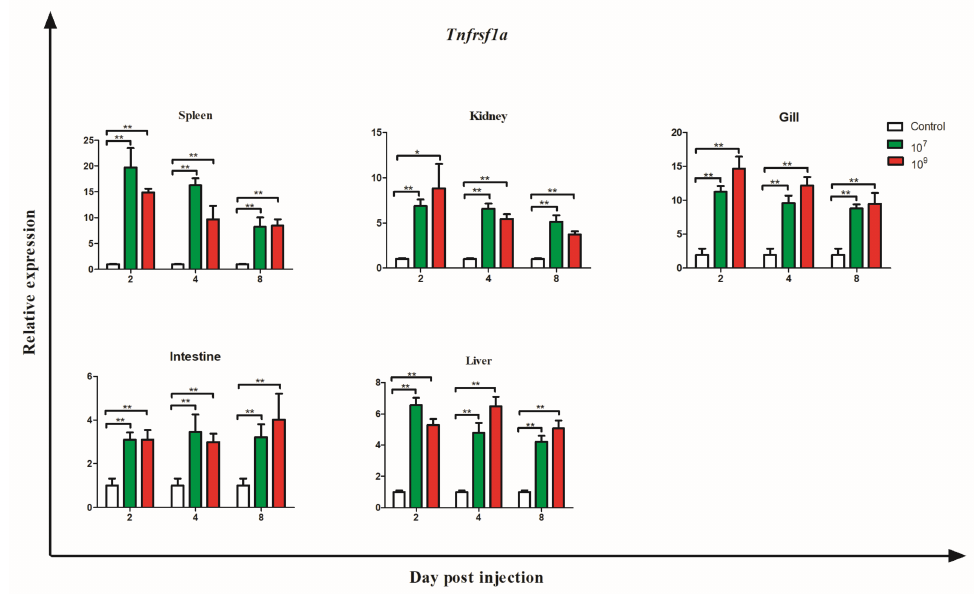
Figure 8. Expression analysis of tnfrsf1a after infection with K. peneumoniae . Fish were i.p. injected with 0.1 mL 1 × 10 7 or 1 × 10 9 CFU/mL K. pneumoniae suspension. Ef-1 α was used as an internal reference gene for normalization of gene expression. The expression levels of genes were compared with that of the control group (defined as 1). Bars represent mean + SEM ( n = 5). Significant differences are indicated by * ( p < 0.05) and ** ( p <